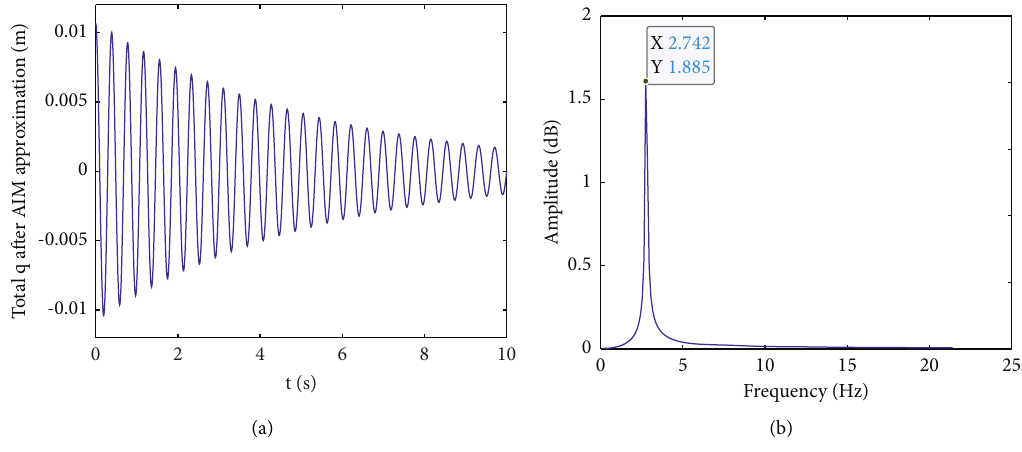
Figure 6: (a) Curve (q) of AIM; (b) spectrum (q) of AIM